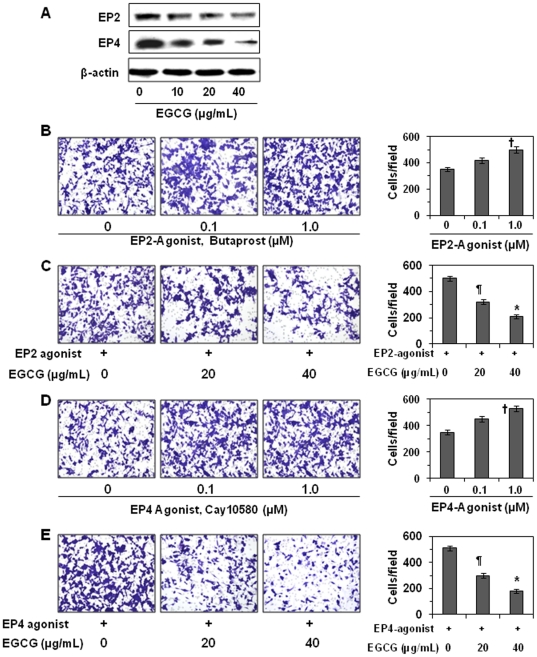
EGCG inhibits PGE2 receptors-induced human melanoma cell migration.(A) Treatment of A375 melanoma cells with EGCG for 24 h decreases the expression levels of PGE2 receptors EP2 and EP4 in a concentration-dependent manner. The cells were harvested 24 h after the treatment and cell lysates were prepared and subjected to western blot analysis, as detailed in Materials and Methods. (B) Treatment of A375 cells with EP2 agonist (butaprost) for 24 h enhances melanoma cell migration (left panels). The data on cell migration are summarized and expressed as a mean number of migratory cells ± SD/microscopic field, n = 3 (right panel). (C) Treatment of A375 cells with EGCG inhibits EP2 agonist (1.0 µM)-induced melanoma cell migration (left panels). The data on cell migration are summarized as a mean number of migratory cells ± SD/microscopic field, n = 3 (right panel). (D) Treatment of A375 cells with EP4 agonist (Cay10580) for 24 h enhances cell migration (left panels). The data on cell migration in each group are expressed as a mean number of migratory cells ± SD/microscopic field, n = 3 (right panel). (E) Treatment of A375 cells with EGCG inhibits EP4 agonist (1.0 µM)-induced cell migration (left panels). The data on cell migration are summarized as a mean number of migratory cells ± SD/microscopic field, n = 3 (right panel). Representative photomicrographs of cell migration were presented from three independent experiments in each case. Significant inhibition versus non-EGCG-treated controls, ¶
P<0.01; *
P<0.001; Significant increase versus non-EP2 agonist-treated or non-EP4 agonist-treated controls, †
P<0.001.